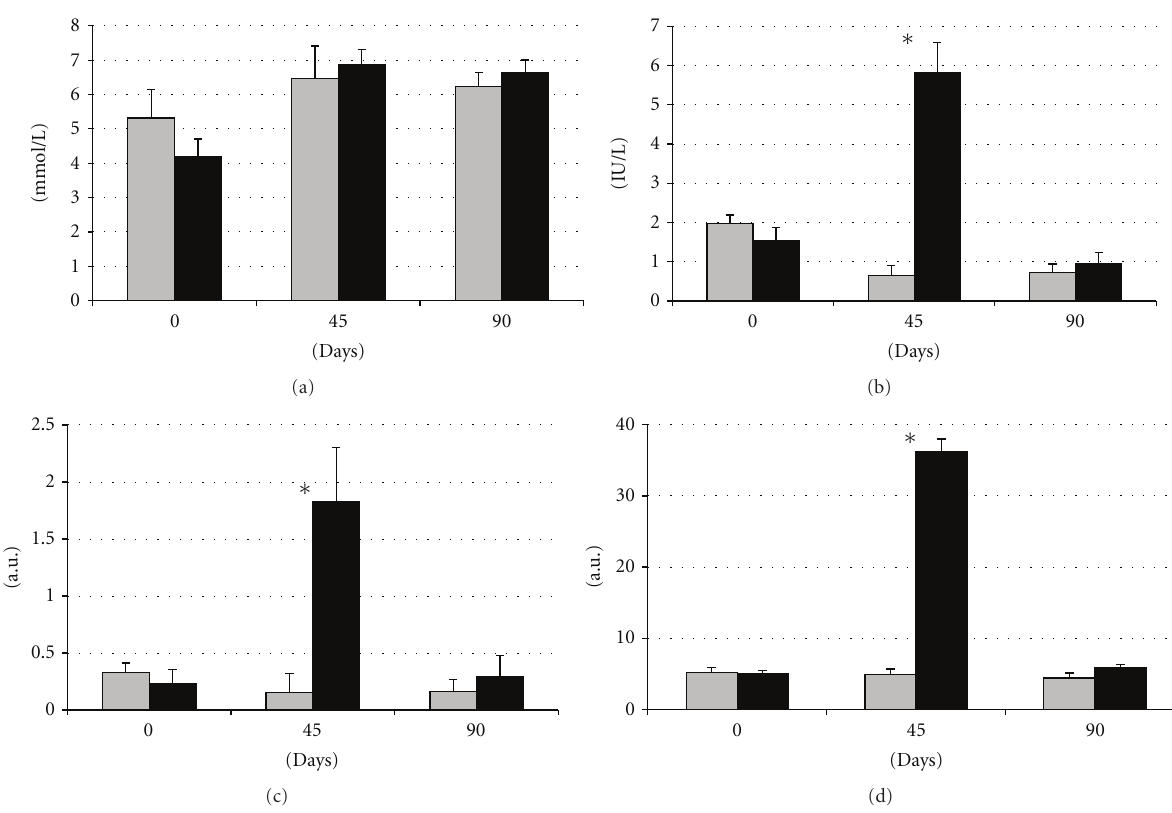
Figure 3: Changes in plasma concentration of glucose (a), insulin (b), and indexes of HOMA-IR and HOMA- β ((c) and (d), resp.) over time after di ff erential feeding in control sows (grey bars) and sows with ad libitum access to a diet enriched with saturated fat (black bars). Asterisks indicate significant di ff erences.